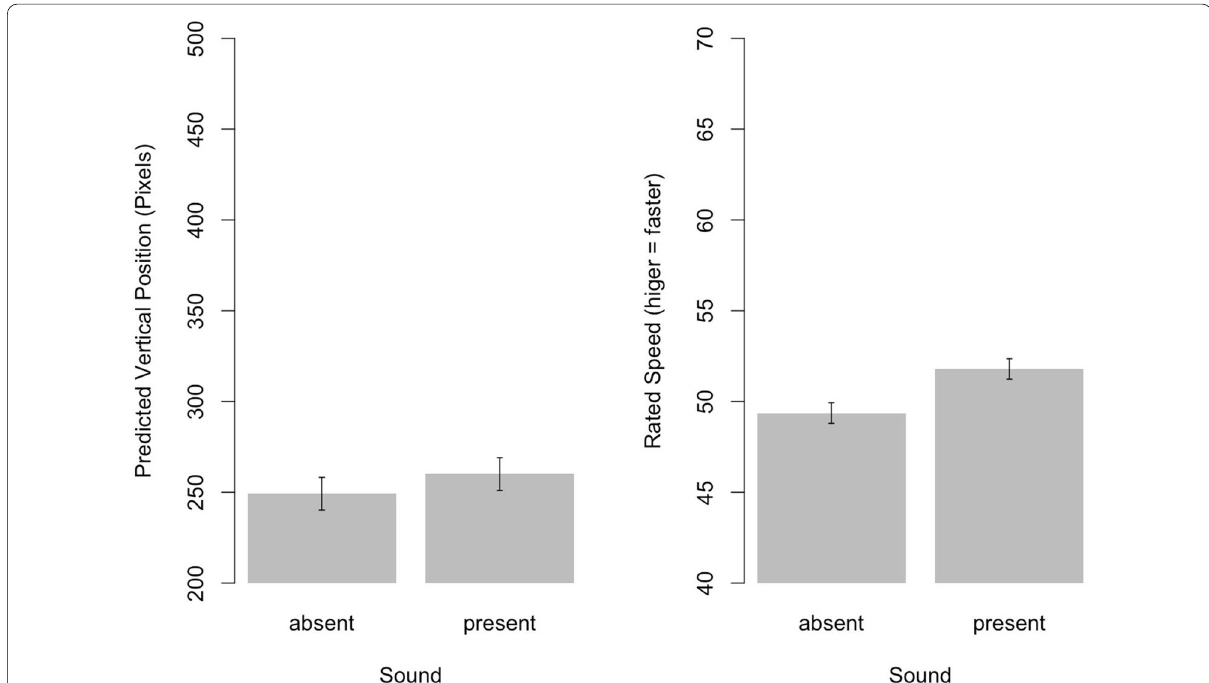
Fig. 5 Effects of sound present vs. sound absent on judgments of the anticipated location in the longitudinal (i.e., vertical) axis (left panel) and speed judgments (right panel). Higher pixel values indicate longer predicted trajectories in the direction of the court baseline. Error bars indicate 95% confidence